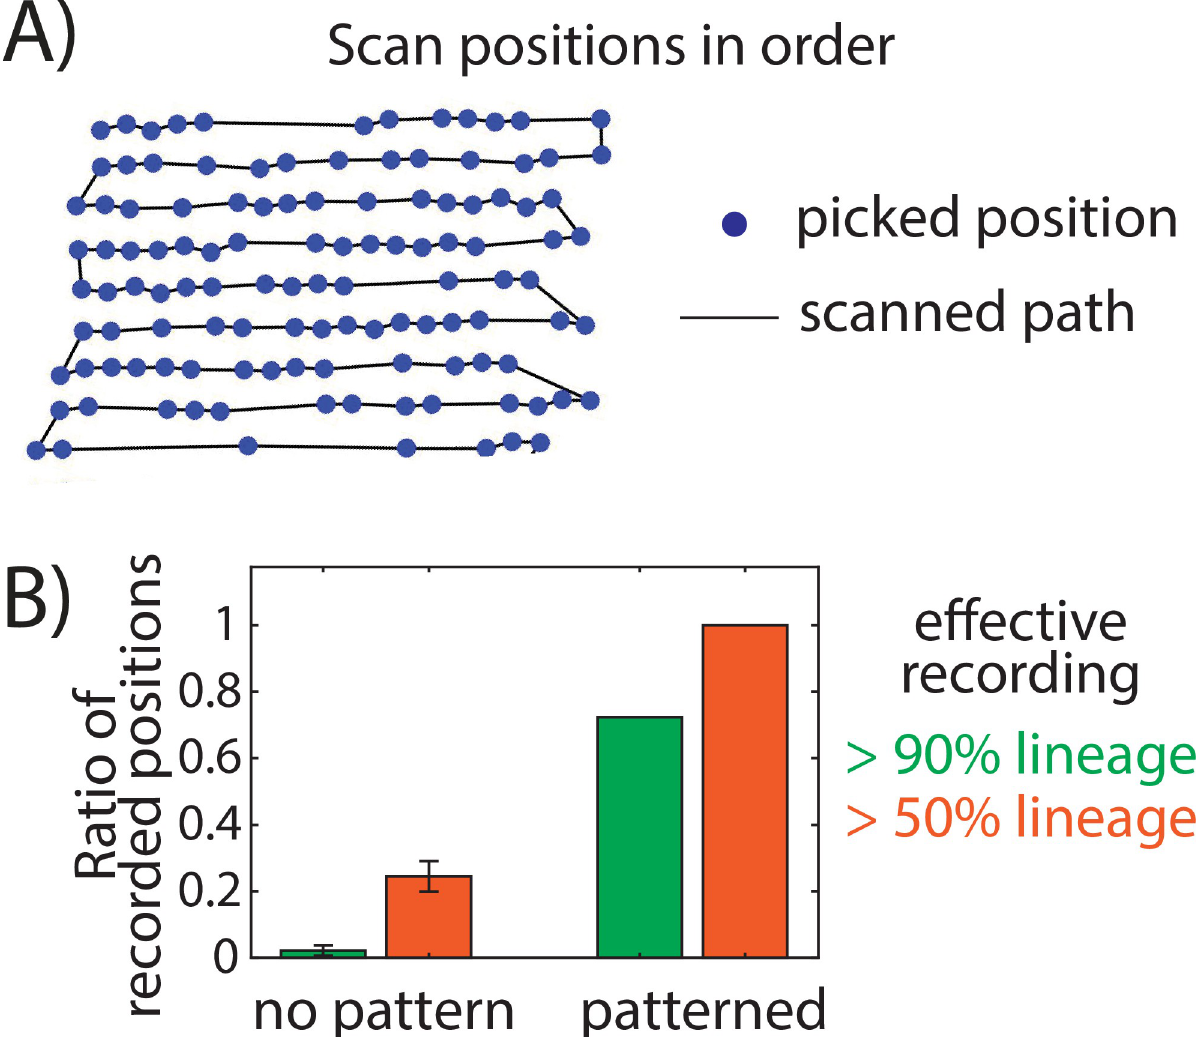
Fig 5. The patterned surface improves the effective-throughput of time-lapse microscopy experiments. A) Microscopy has scanned the stage positions in order. B) The majority positions of a patterned surface can record the full lineage of a cell colony, with a ratio significantly higher than the no-pattern